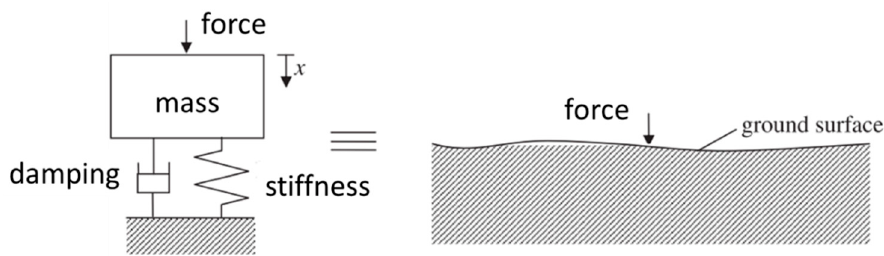
Figure 8. The ground as a single-degree of freedom system [90].